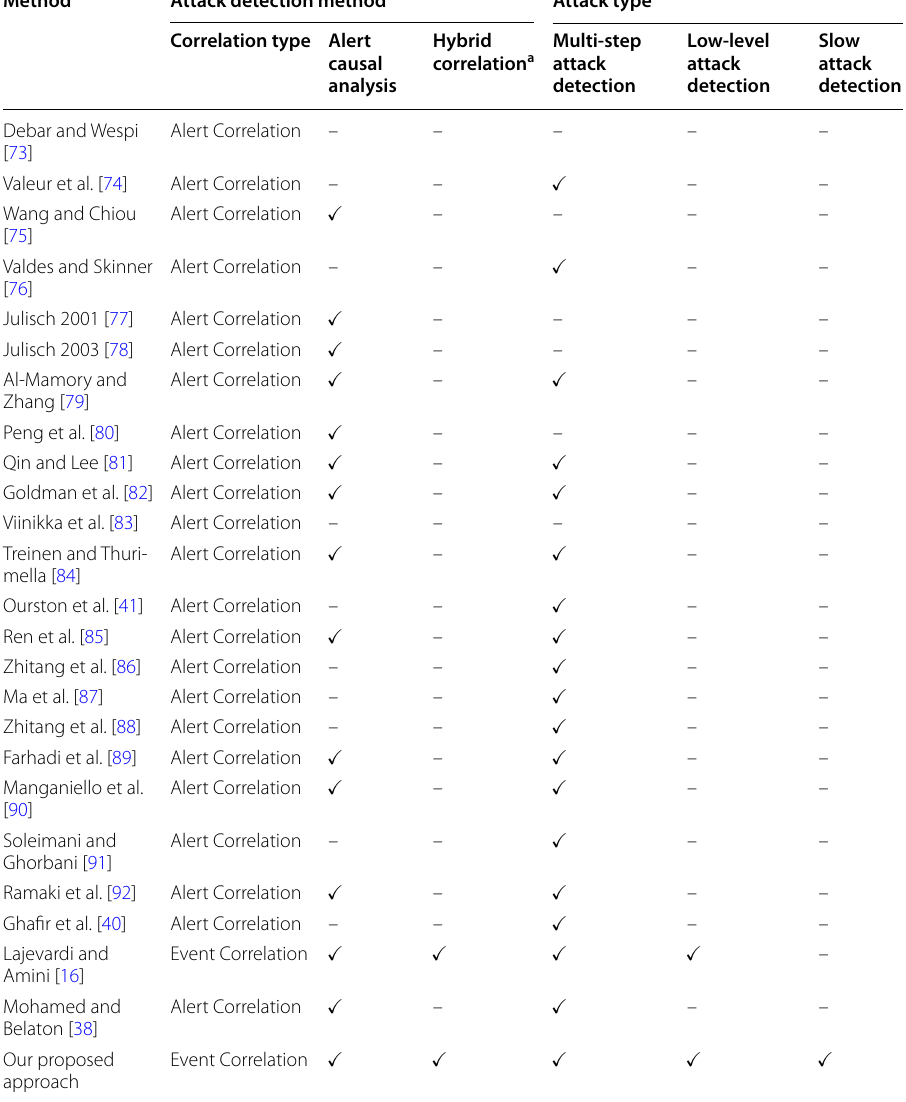
a Hybrid correlation means correlating operating system events with network